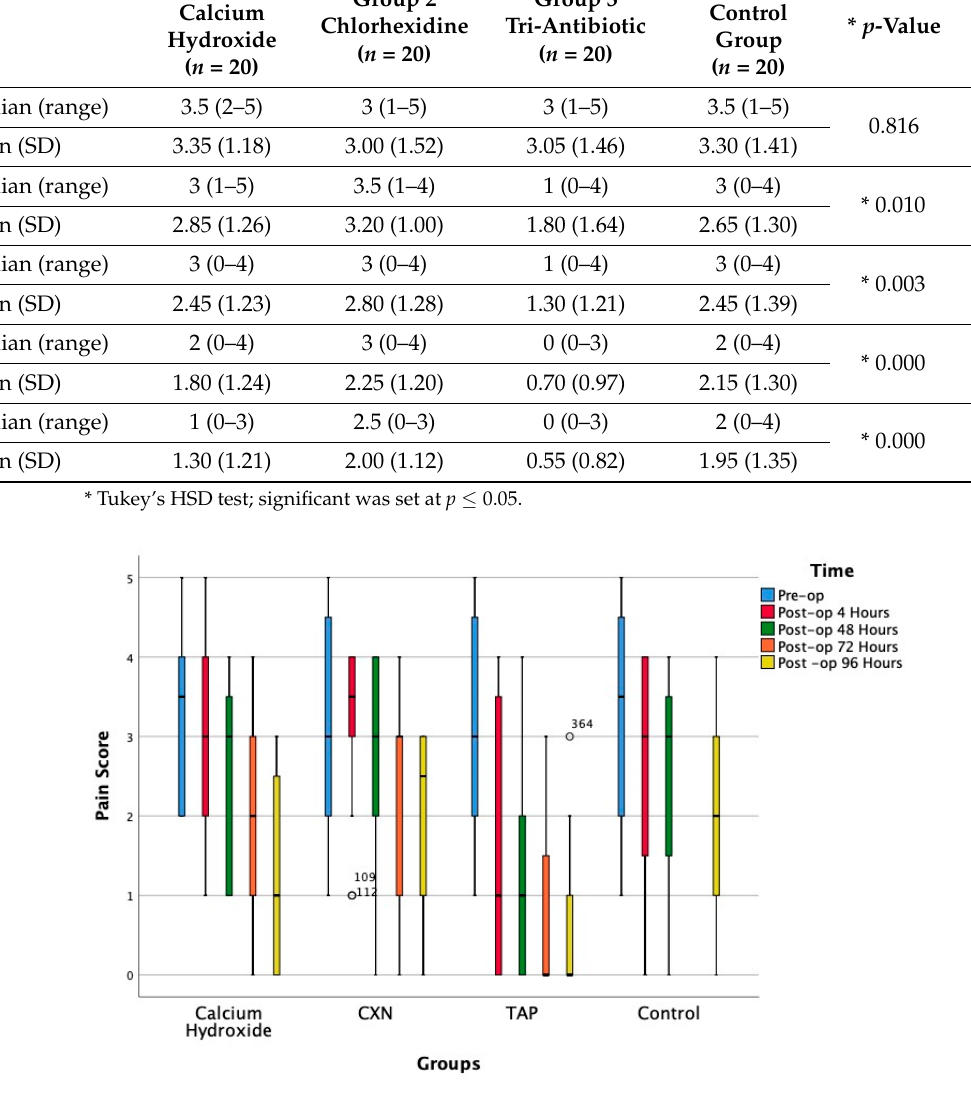
Table 2. Median (range) and mean (± SD) pain (WFPRS) scores in the four groups.